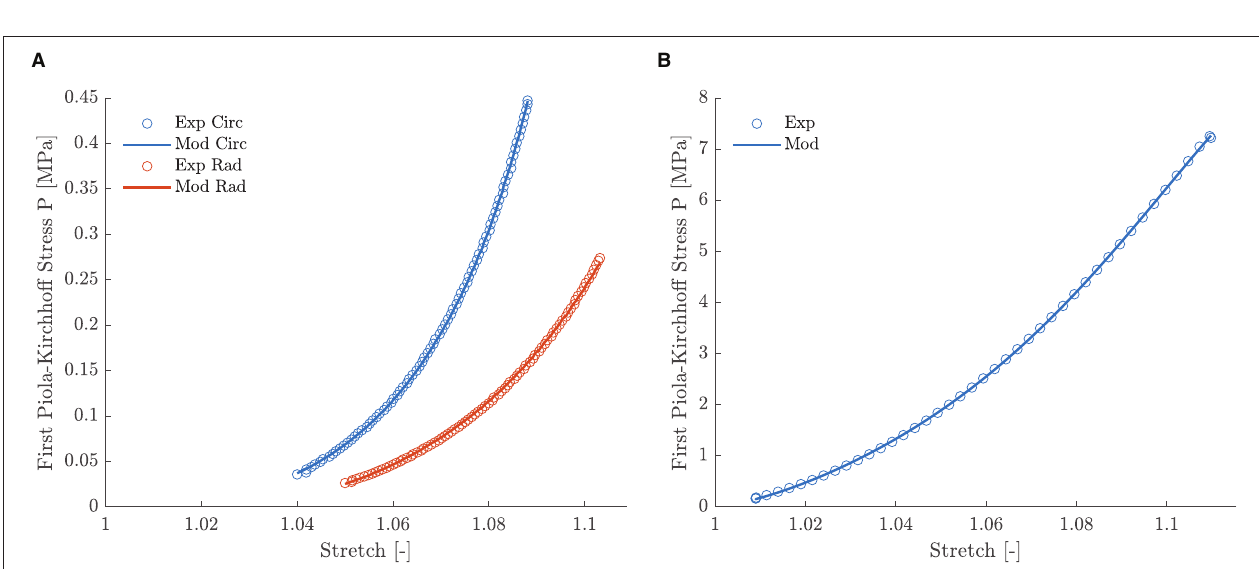
and high significance was indicated with